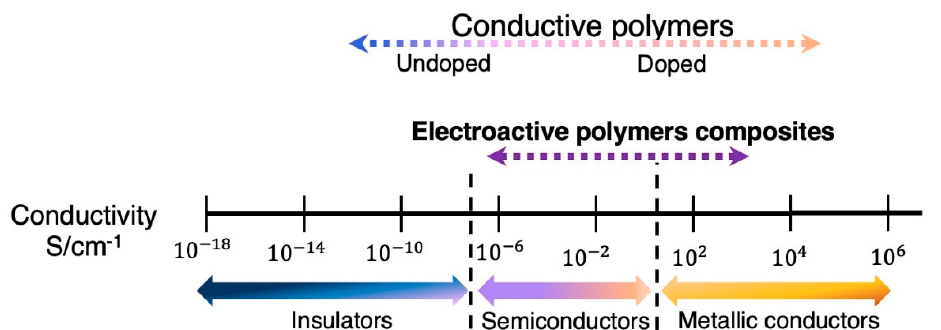
Figure 4. Conductivity range of intrinsically conductive polymers and electroactive conductive composites. Based on reference composites. Based on reference [29].